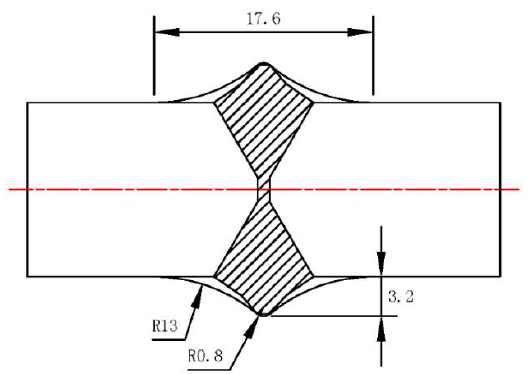
Figure 9. EFBC design results of Q550d (ER50-6) butt-welded joints.